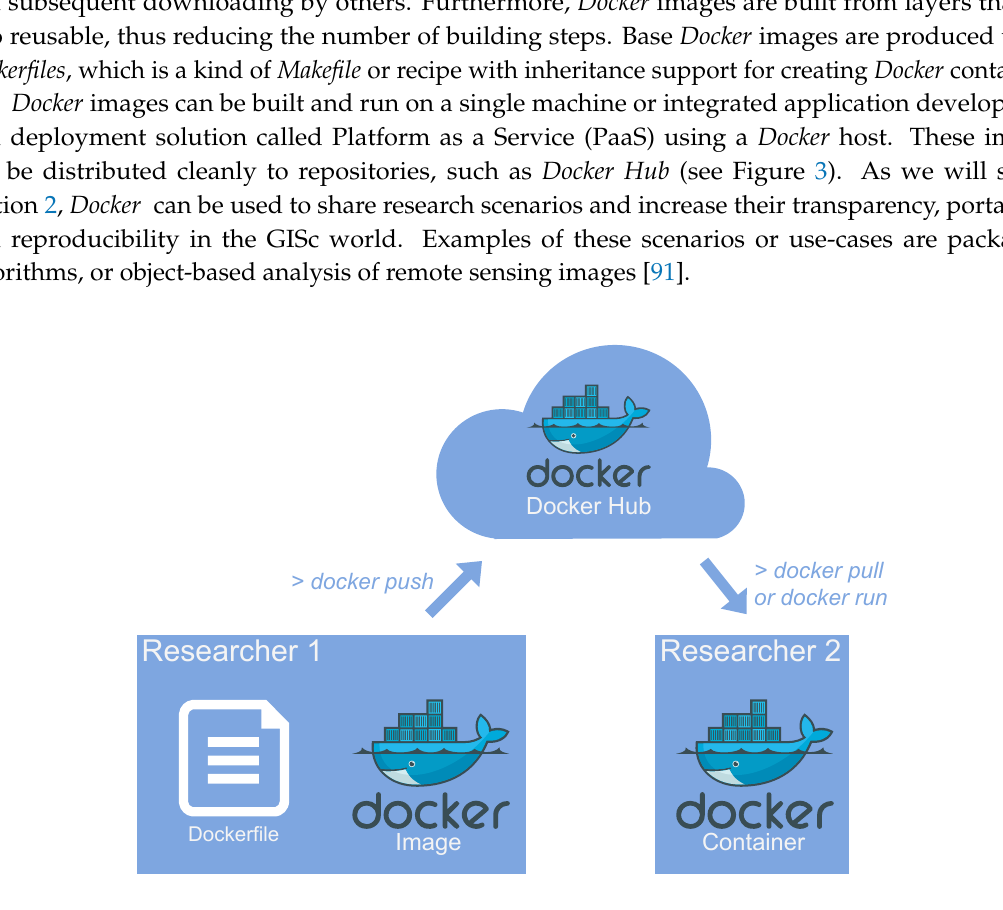
Figure 3. Docker Hub ecosystem and packaging of compiled